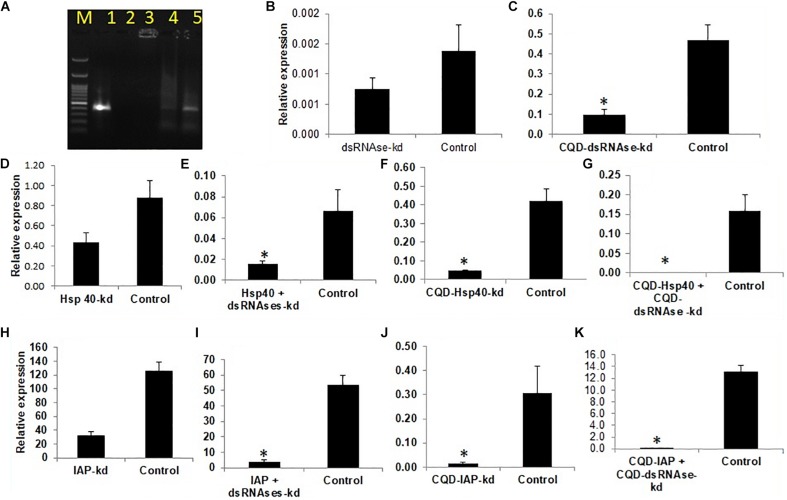
(A) Affinity of CQD nanoparticles at different dilutions with fived concentration of dsRNA.M -100 bp ladder 1- Control, 2-1:100,3-1:200,4- 1:500,5- 1:800, (B)
dsRNAses knockdown- 45% (C)
CQD-dsRNAses-79.08% (D)
Hsp40 knockdown 61.7% (E)
Hsp40 + dsRNAses knockdown -77.1% (F) CQD- Hsp40 knockdown 88.9% (G) CQD- Hsp40 + CQD-dsRNAse knockdown 99.4% (H)
IAP knockdown 74.3%
(I)
IAP + dsRNAses knockdown- 92.54% (J)
CQD-IAP knockdown 95.2% (K) CQD-IAP + CQD-dsRNAse knockdown 99.6%. The error bar represents the standard deviation (n = 3) and * represents significant differences in mRNA transcripts compared to the control (P ≤ 0.05, Student’s t-test).